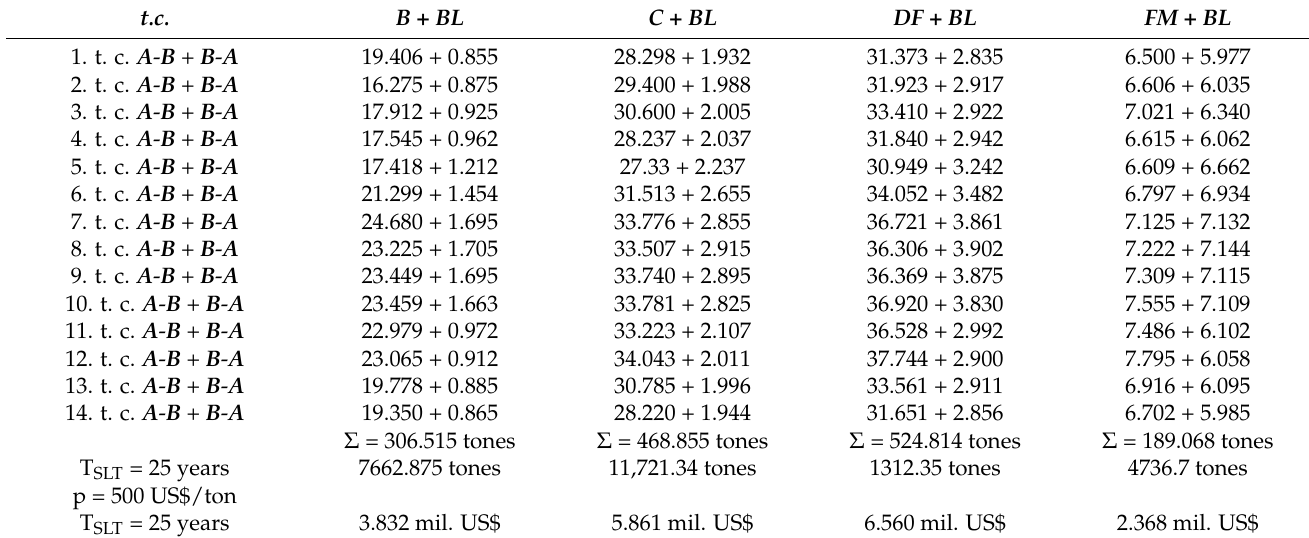
Table 2. Fuel savings for a combination laden voyage from A to B and a ballast voyage ( BL ) from B to A , where: t.c .— transport cycle, B —bananas, C —citruses, DC —deciduous fruits, FM —frozen meat. t.c. B + BL